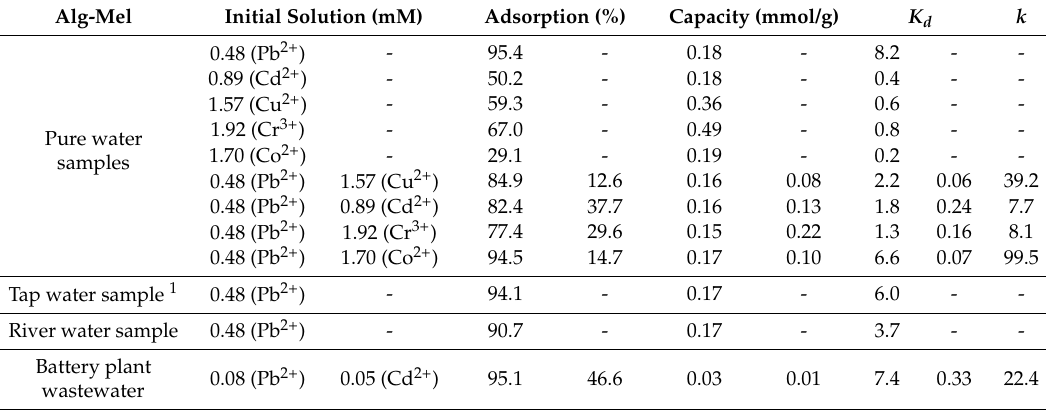
Table 1. Adsorption abilities of Alg-Mel for various metal